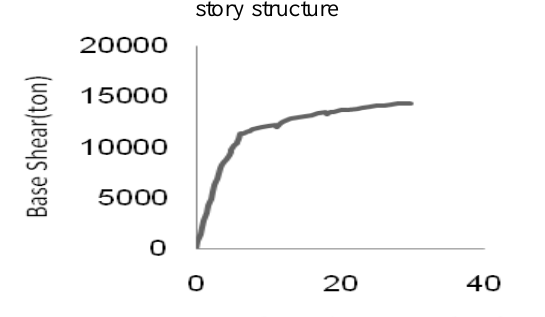
Fig. 6. Base shear - roof displacement curve for ten story structure